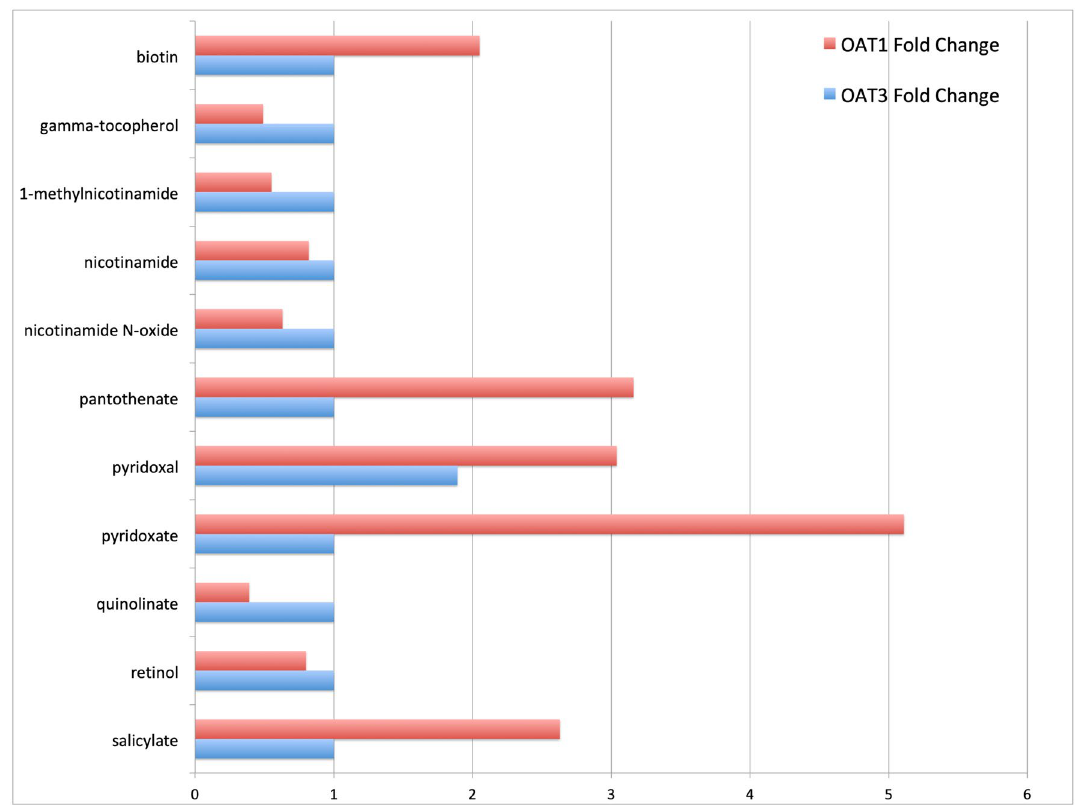
Figure 7. Changes in vitamin concentrations in OAT1 and OAT3. Relative ratios (KO/WT) of vitamin and vitamin precursor concentrations for the OAT1 and OAT3 knockouts. The changes in the availability and transport of these metabolites in the context of the altered microbiome interactions as well as organ-organ interactions, such as the kidney-liver-colon axis, suggests there may be nutritional consequences resulting from loss of OAT